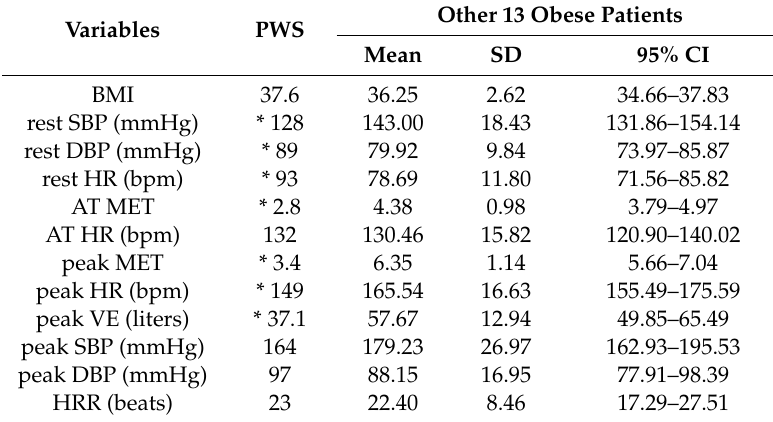
Table 3. CPET results of the obese Prader-Willi syndrome (PWS) patient and other 13 obese patients in our hospitals. Variables